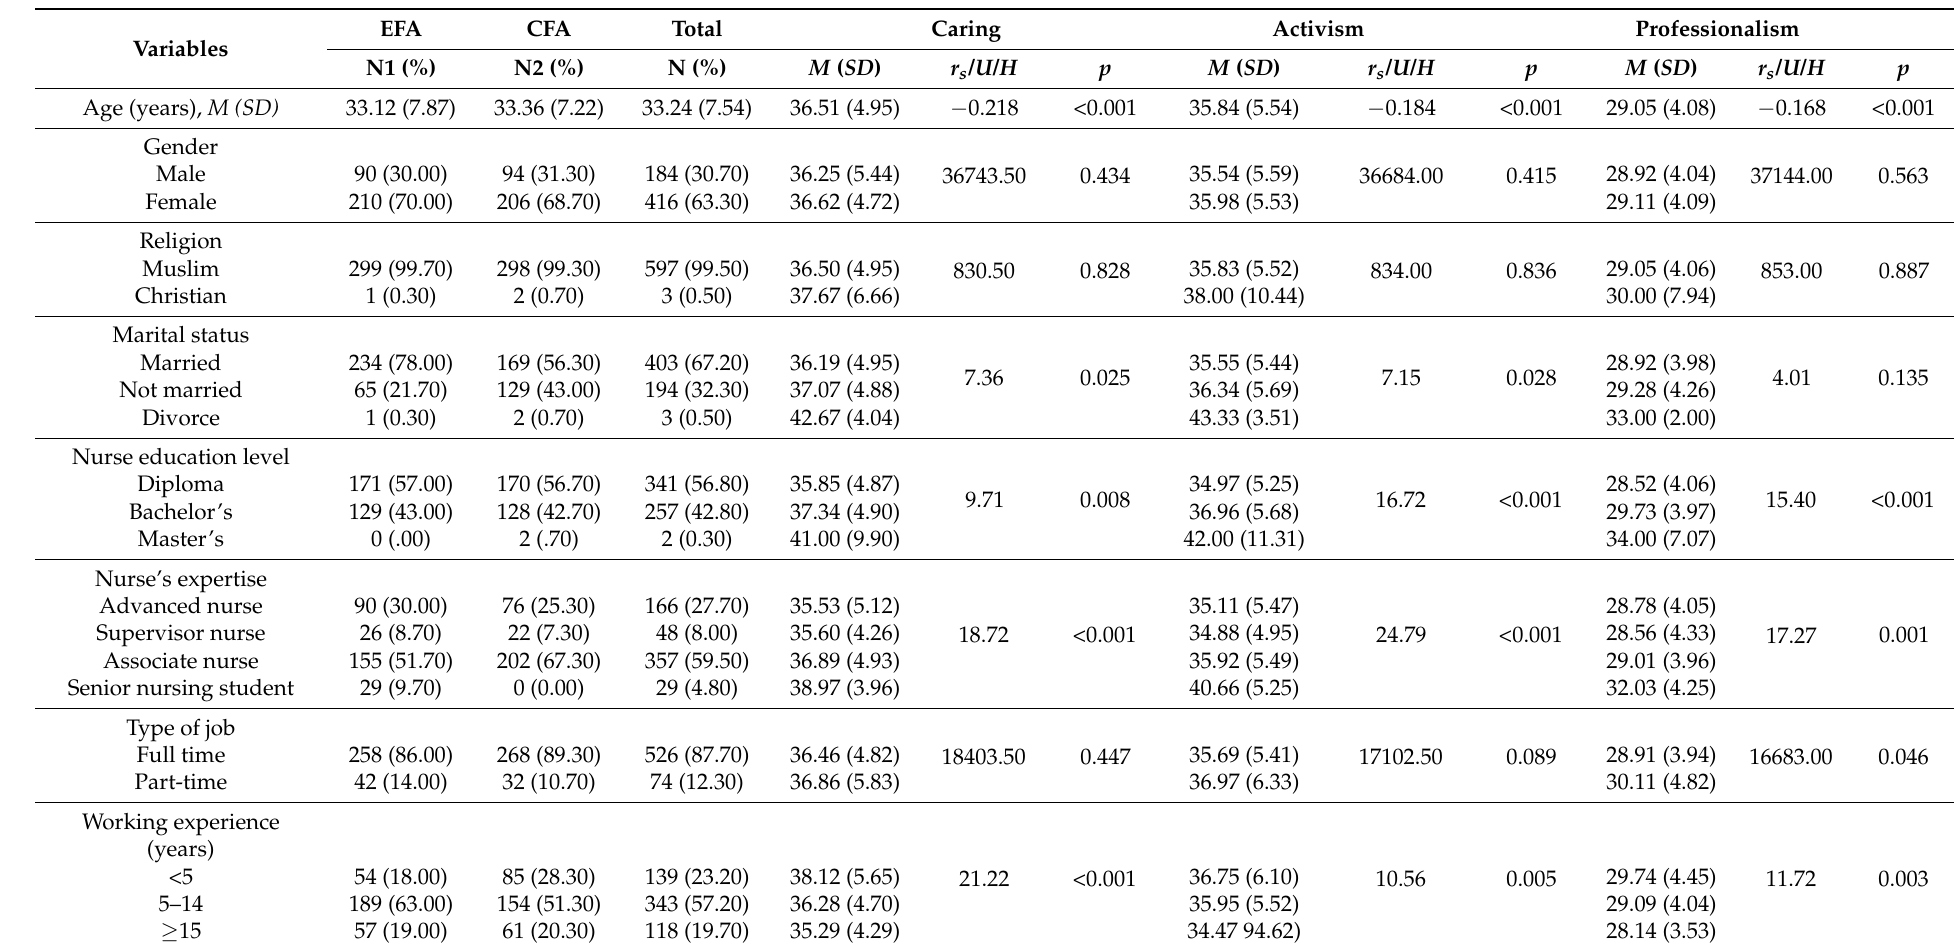
Table 1. Demographic variables, work-related variables, and nurses’ professional values ( n =